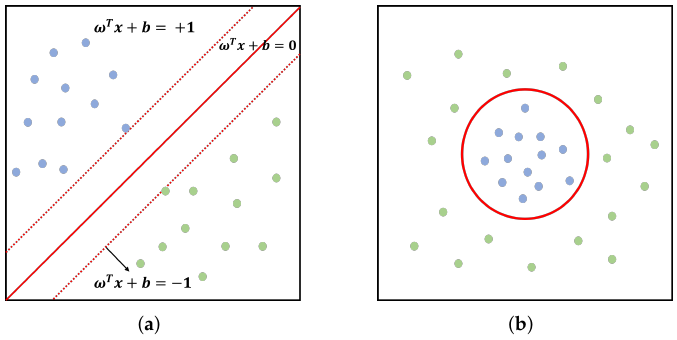
Figure 8. Hyperplanes in SVM. ( a ) Hard-margin; ( b )